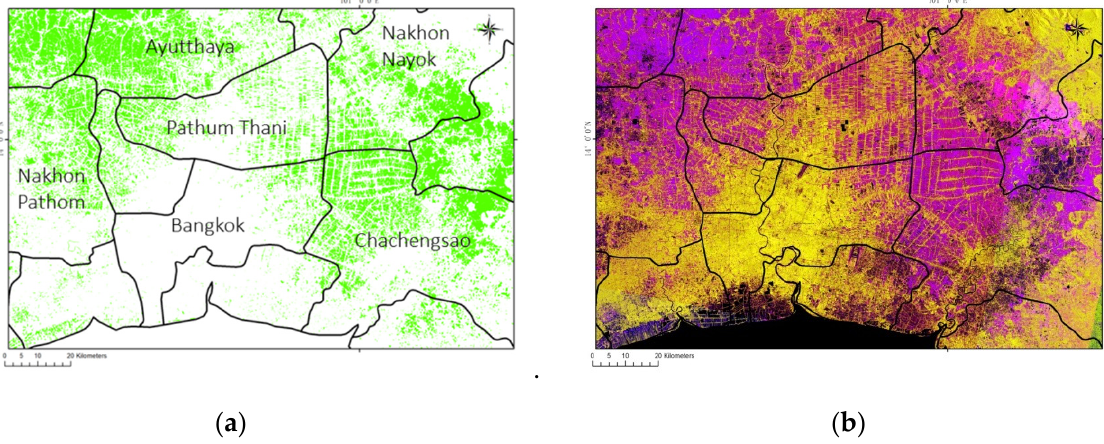
Figure 18. Paddy rice mapping result of Bangkok (central Thailand): ( a ) paddy rice mapping result and ( b ) false-color image of the temporal features.